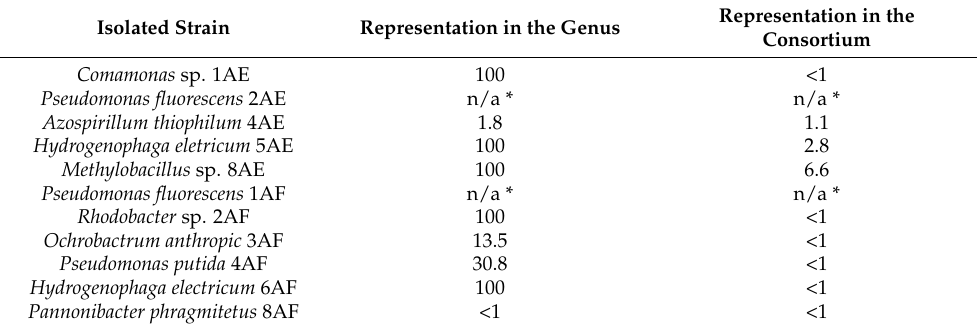
Figure 5. 16S rRNA amplicon sequencing data for the FLU-enriched consortium at the beginning and at the end of a 21-day incubation period with 5 mg.L − 1 of FLU. Figure panels show the alpha rarefaction curves (panel A ), the bacterial consortium structure at the family or genus levels (panel B ), and the relative abundance variations observed during the 21-day incubation period with FLU (panel C ). The number of amplicon reads obtained for each bacterial taxa is shown in Table S2. Table 2. Representation percentage (%) of the bacterial strains isolated from the consortia enriched with EPO (AE) and FLU (AF) in these consortia and in the corresponding genus, at the end of a 21-day incubation period, based on local BLAST analyses.